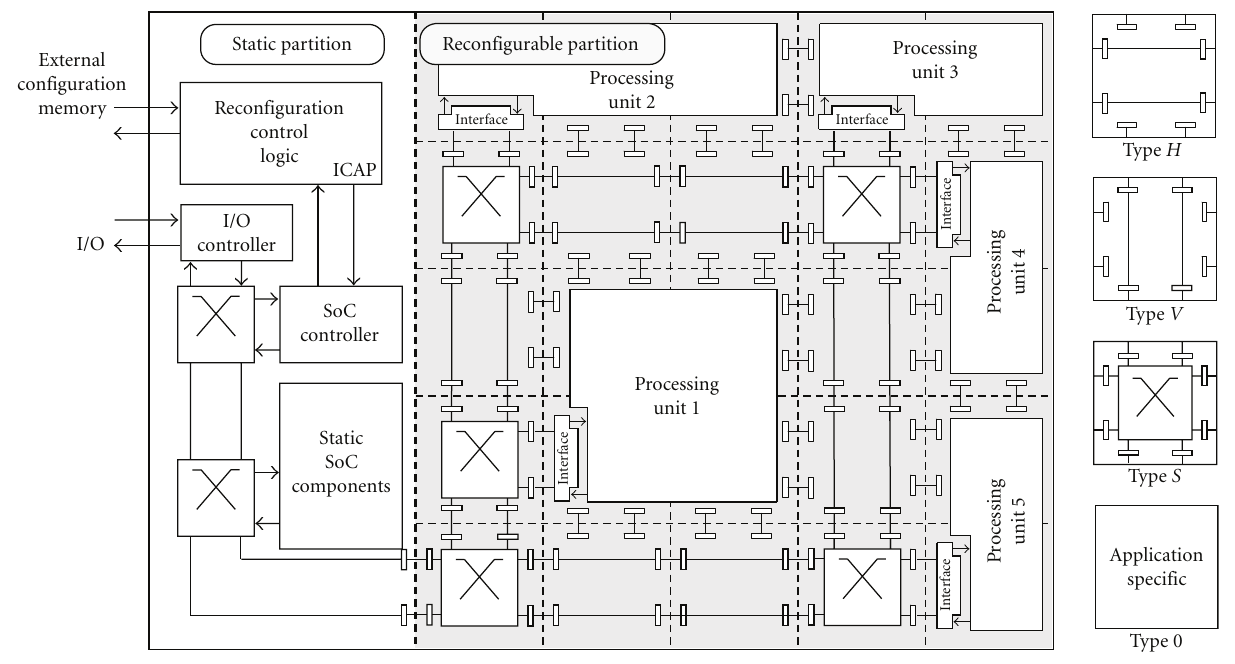
Figure 1: System architecture